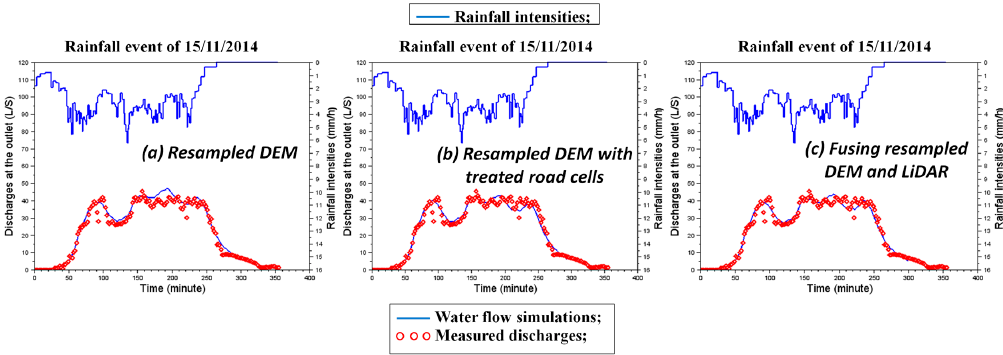
Figure 10. Hydrographs at the outlet of catchment using different topographic input maps. For ( a ) directly resampling the DEM data (25 m) to 5 m resolution; ( b ) resampling the DEM data (25 m) to 5 m resolution, and then lowering the identified road grid cells by 20 cm; ( c ) resampling the road LiDAR data (20 cm) and the DEM data (25 m) to 5 m resolution, then fusing the two types of data together. The simulated discharges at the outlet (solid blue line) are compared with the measured data (red circles). Rainfall is plotted on the upper part. Table 7. Influence of high ‐ resolution road topographic data on water flow at the outlet of the sewer system.